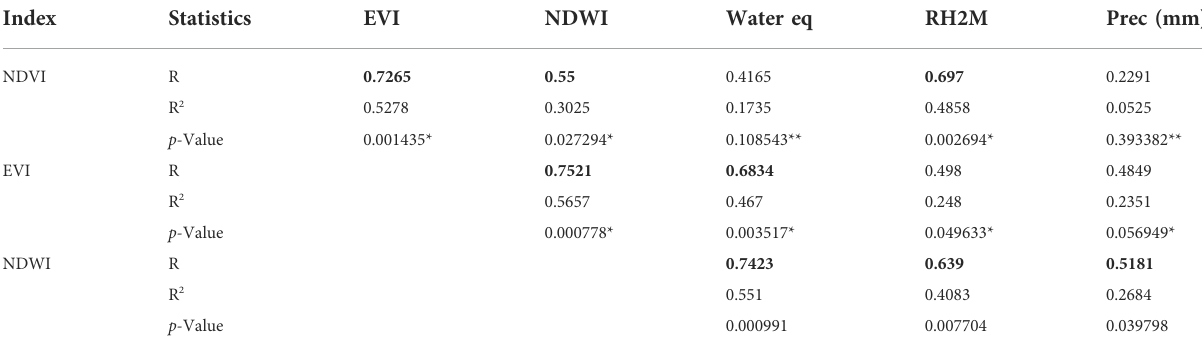
TABLE 2 Correlation between the RS variables using the Social Science Statistics calculator. R, Pearson Correlation Coef fi cient, and R 2 is the coef fi cient of determination. Bold values refer to moderate to strong